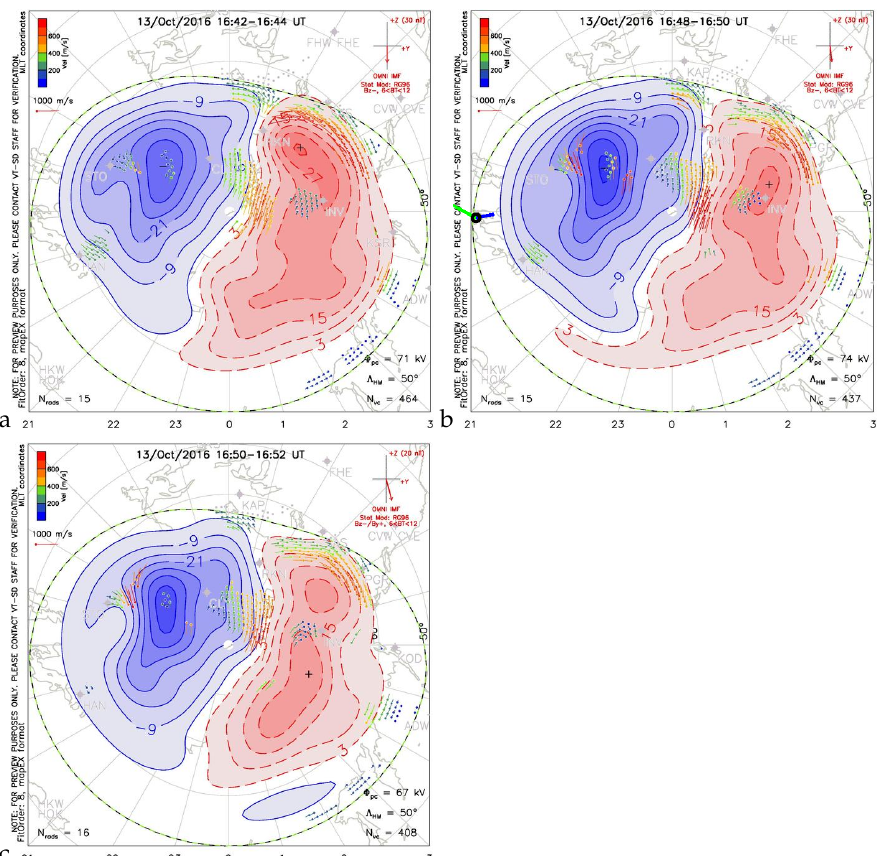
Figure 17. Details of the convection pattern change around 16:48 UT for the set L552177; panel ( a ) for 16:42 UT just before estimation time 16:48 UT (panel b ), and panel ( c ) for 16:50 (just after estimation